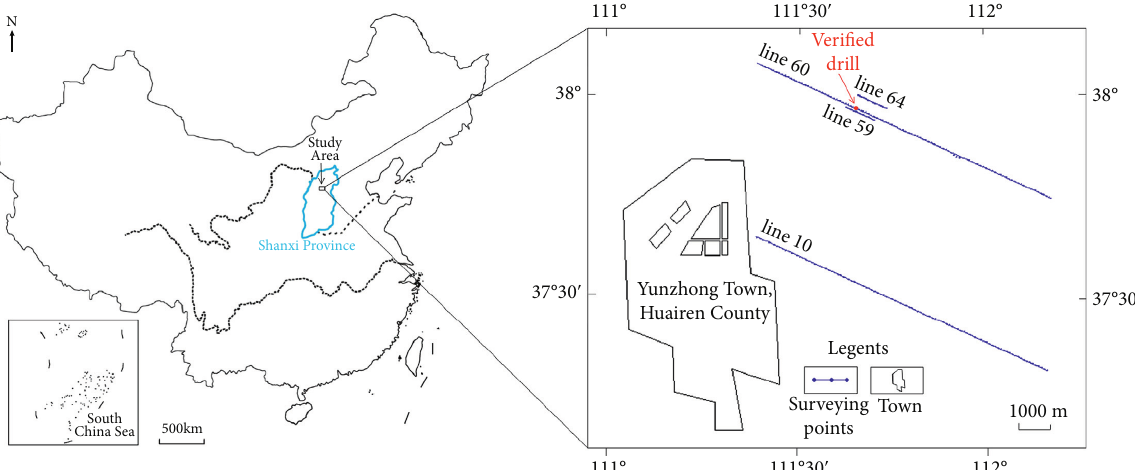
Figure 5: Project layout that contains the location of the study area in Shanxi Province in northern China, showing the base map of the study